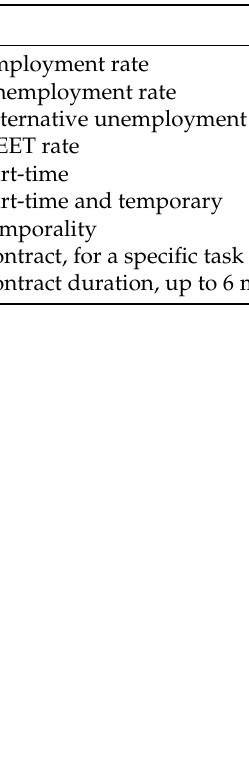
Table 5. Employment, unemployment, and temporality rates, second term of